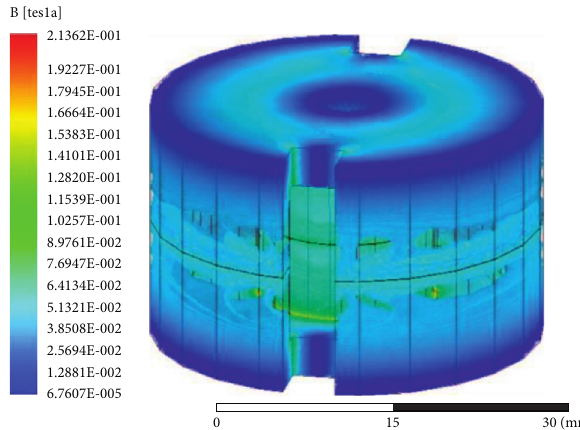
Figure 14: Core simulation with duty cycle D � 0.375.